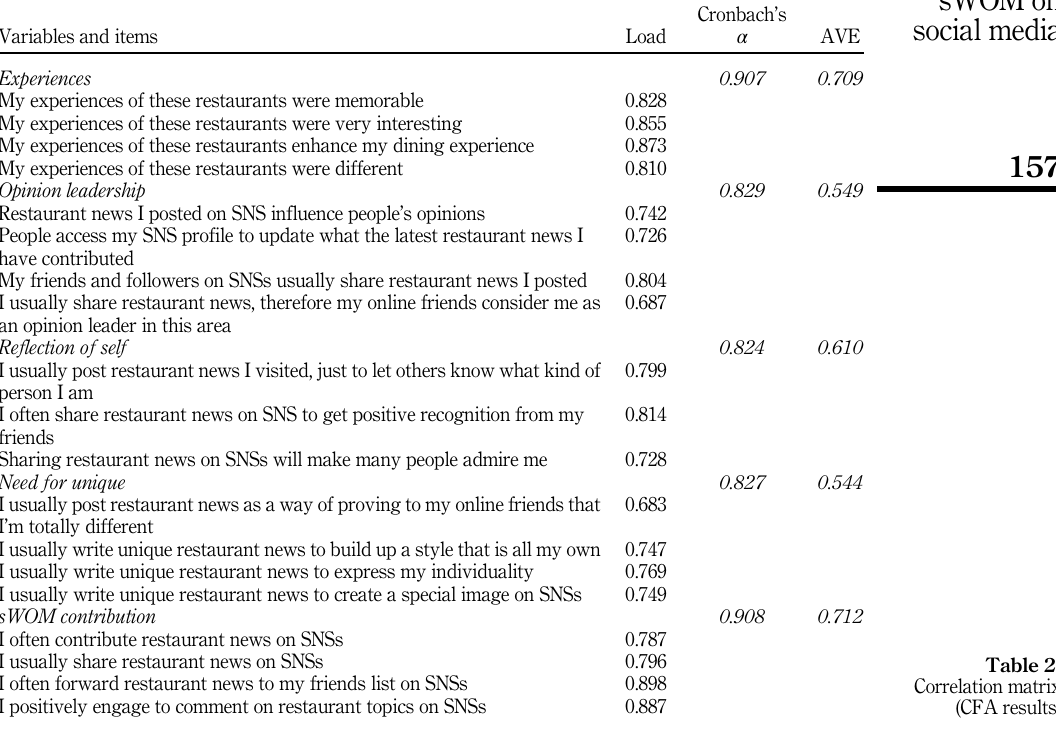
Table 2. Correlation matrix